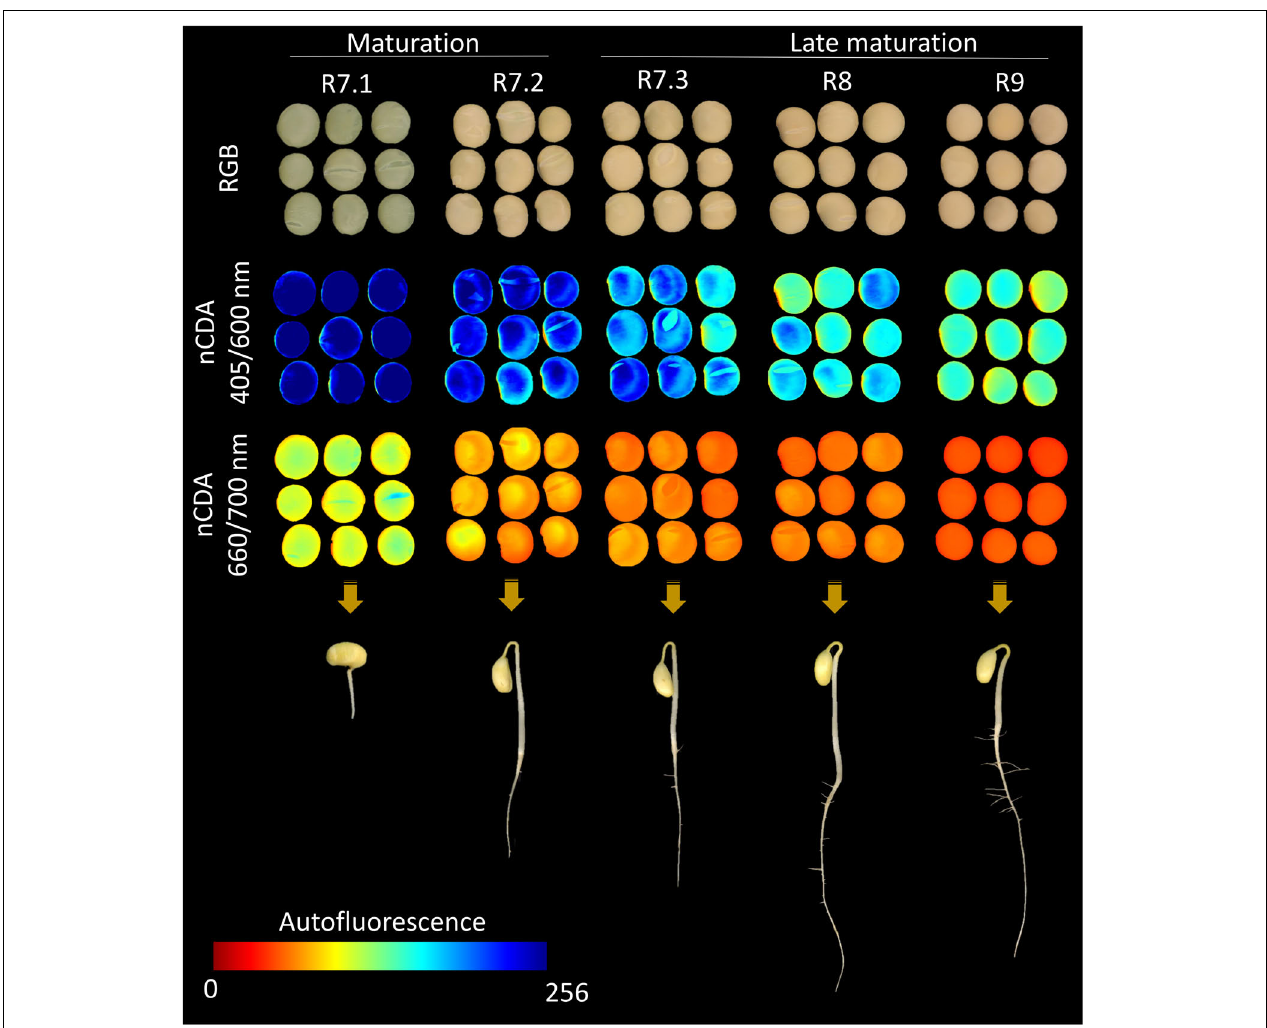
FIGURE 6 | Framework of soybean seeds at different maturation stages assisted by RGB images (each individual pixel is represented by red, green and blue channels) and corresponding autofluorescence-spectral images captured in the excitation/emission combinations of 405/600 nm (chlorophyll b ) and 660/700 nm (chlorophyll a ), after image transformation by the nCDA algorithm. The seedling images were captured at 7 days after sowing using a representative seedling of each maturation